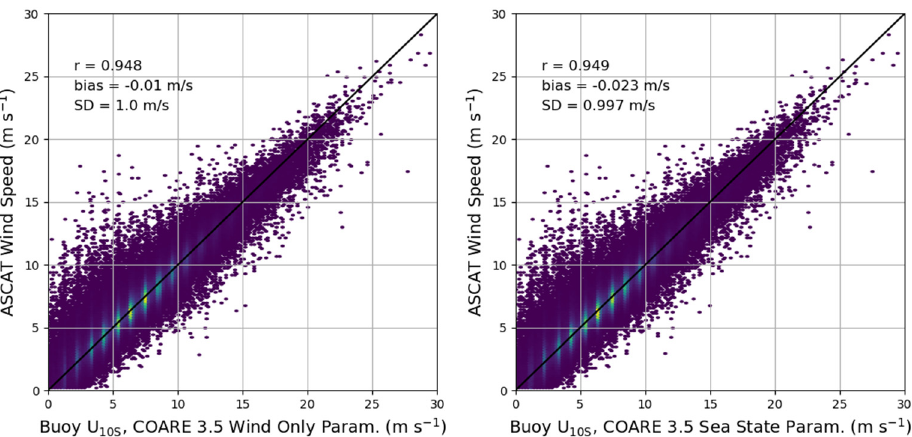
Figure 2. Scatterplots of buoy U 10 S and ASCAT with buoy U 10 S derived from the wind-speed only parameterization ( left ) and buoy U 10 S derived with the sea state dependent parameterization ( right ). The solid black lines are the 1 − to − 1 line on both plots. Color shading represents observation density.